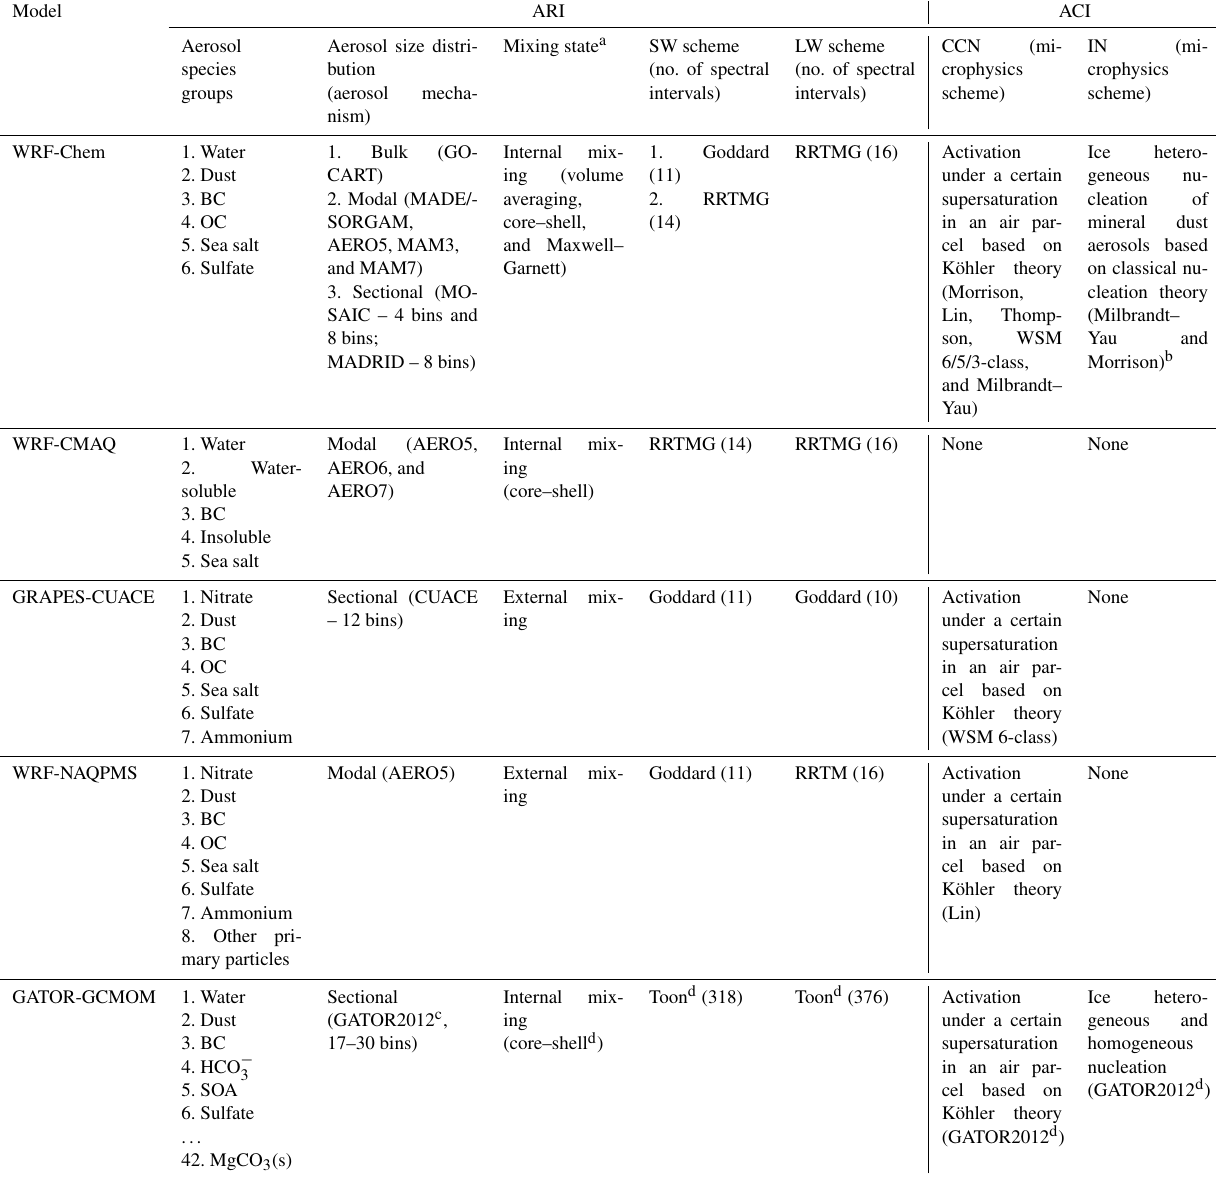
Table 4. Summary of relevant information regarding calculations of aerosol–radiation interaction (ARI) and aerosol–cloud interaction (ACI) in two-way coupled models (WRF-Chem, WRF-CMAQ, GRAPES-CUACE, WRF-NAQPMS, and GATOR-GCMOM) applied in Asia.